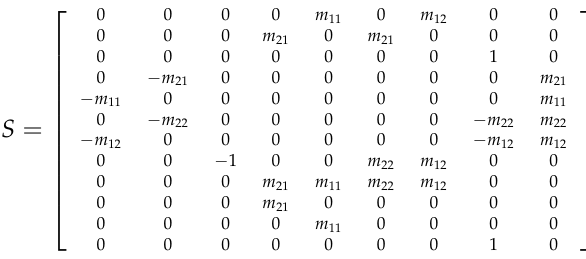
The resolution of this last equation seeks a coupling with respect to the unknown variables.